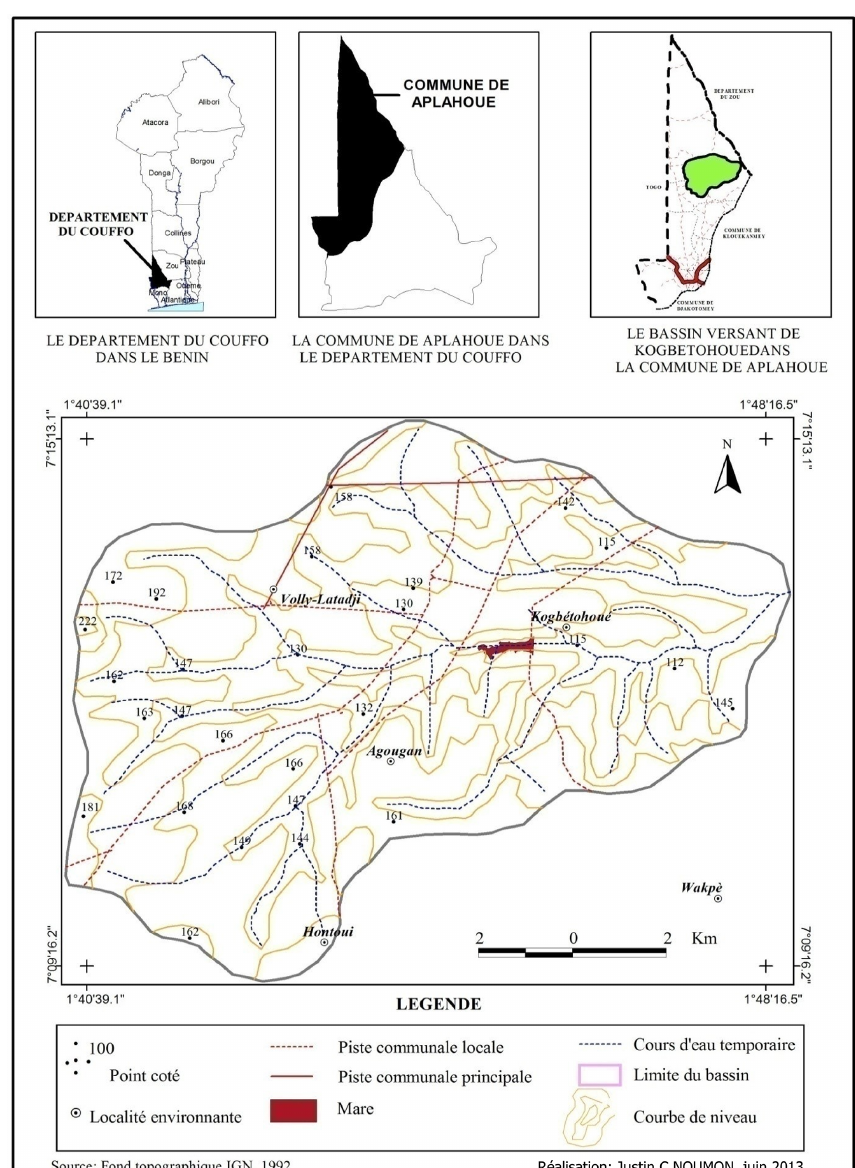
Figure 1. Carte de situation de la zone